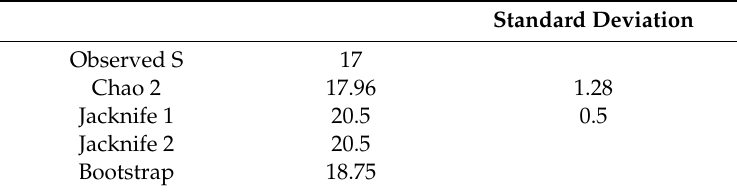
Table 8. Estimation of termite total species richness for the two